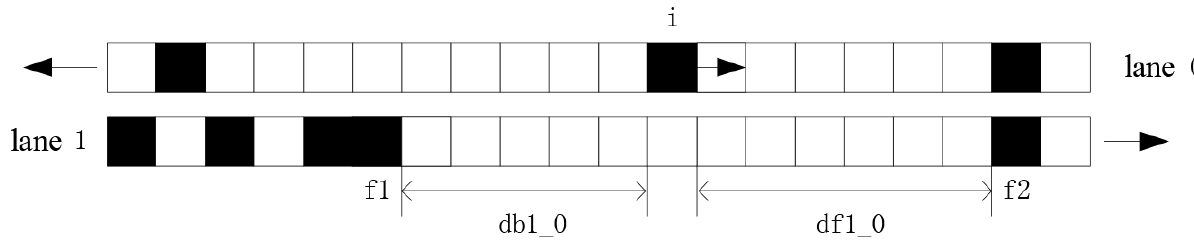
Figure 2. Sketch-map for sailing